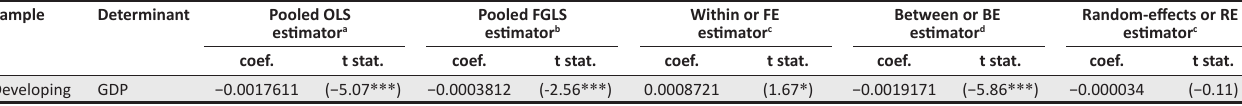
TABLE 7: Variation of Corruption Perceptions Index depends on gross domestic product, by stage of development: Developing. Sample